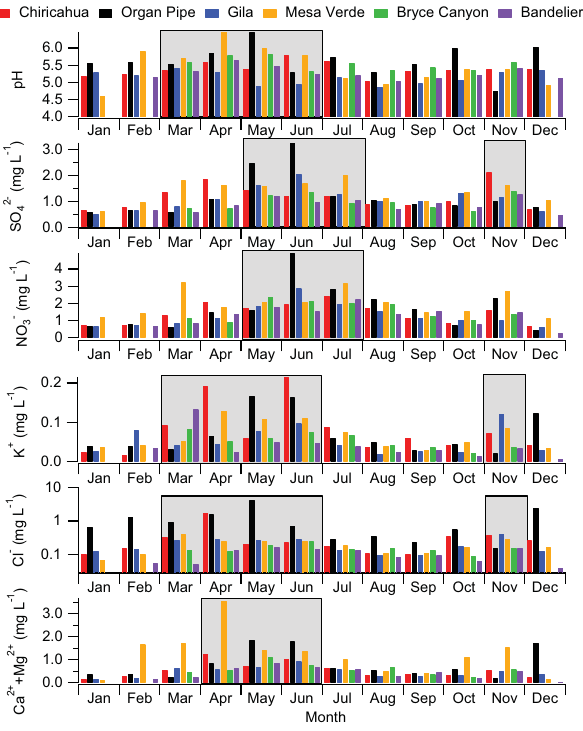
Fig. 8. Annual pH and concentration profiles for rain in the South- west. Shaded regions represent when maxima are observed for in- dividual or groups of sites. These results are based on data ranges shown in Table 1 for each